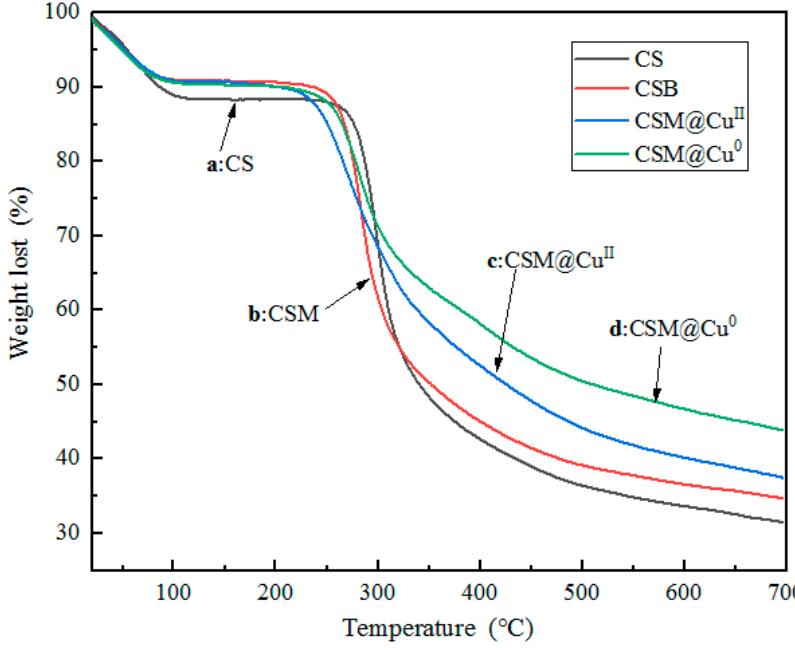
Figure 4. Thermal Gravimetric (TG) curves of the thermal degradation of ( a ) chitosan (CS), ( b ) modified chitosan microspheres (CSM), ( c ) Cu 2+ -loaded modified chitosan microspheres (CSM@ Cu II ), and ( d ) Cu-loaded modified chitosan microspheres (CSM@Cu 0 ).